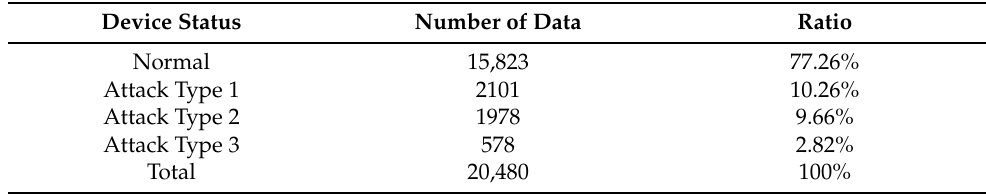
Table 3. Dataset used in the